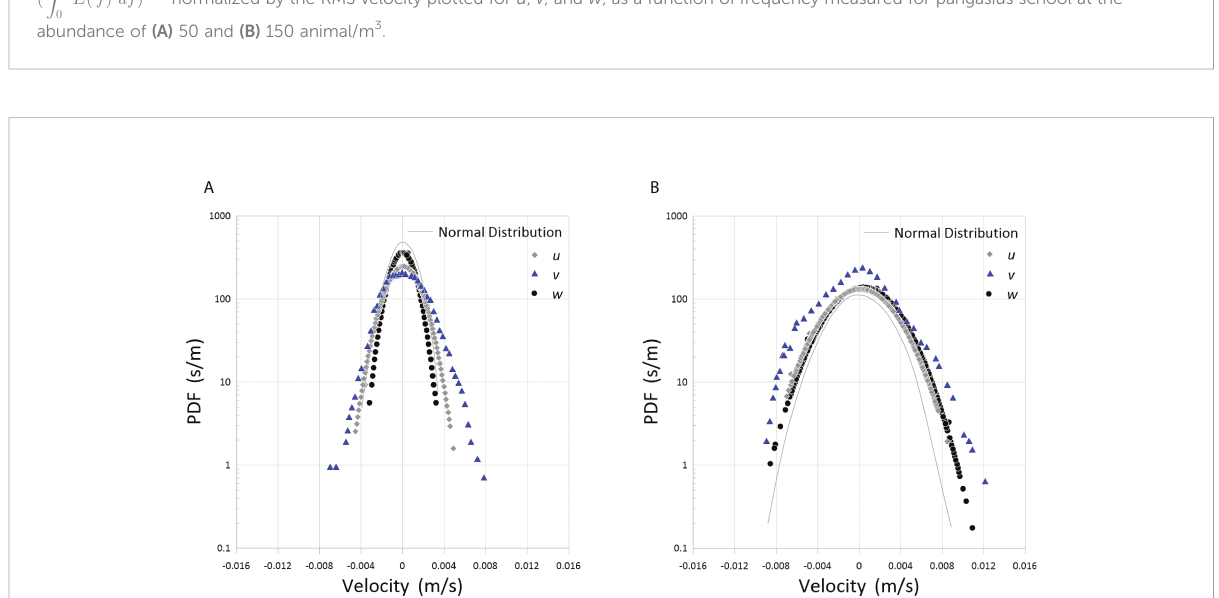
FIGURE 5 PDFs of the fl uctuating velocities measured with pangasius at two abundances of (A) 50 and (B) 150 animal/m 3